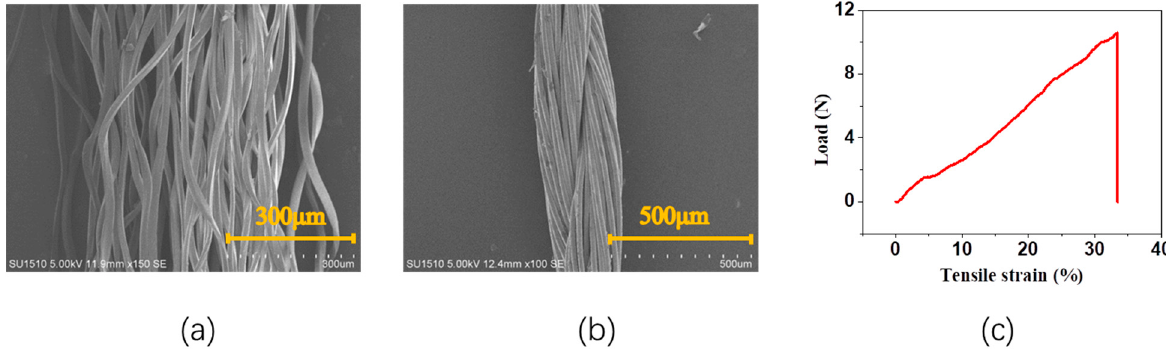
Figure 1. ( a ) Scanning electron microscopy (SEM) photograph of PET multifilament; ( b ) SEM of PA conductive yarn; ( c ) tensile property of the PAconductive yarn.